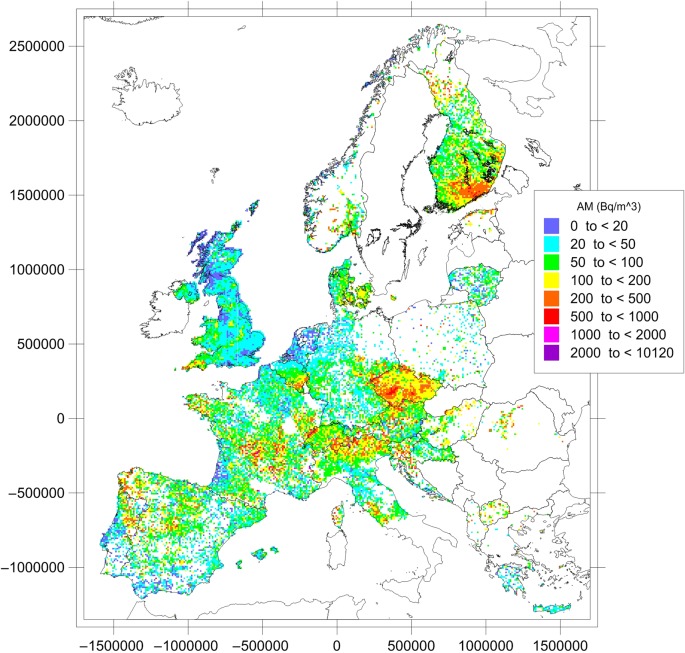
Arithmetic means over 10 × 10 km cells of long-term radon concentration in ground-floor rooms. Data available until May 2014 included.